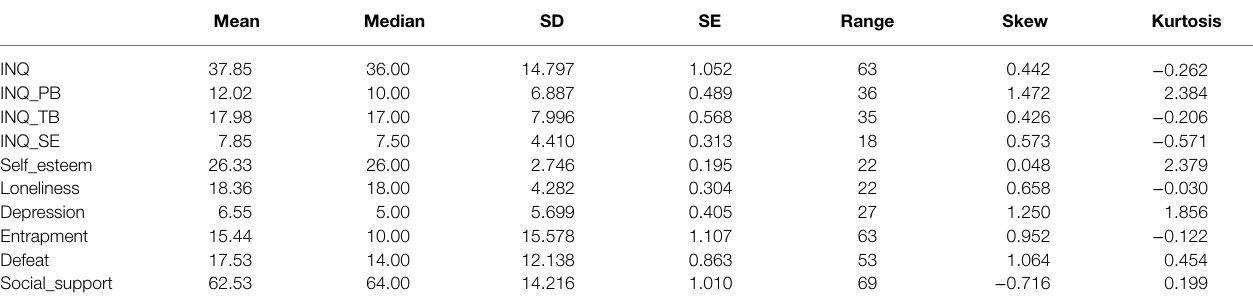
TABLE 5 | Descriptive statistics of the psychosocial factors. Mean Median SD SE Range Skew Kurtosis INQ